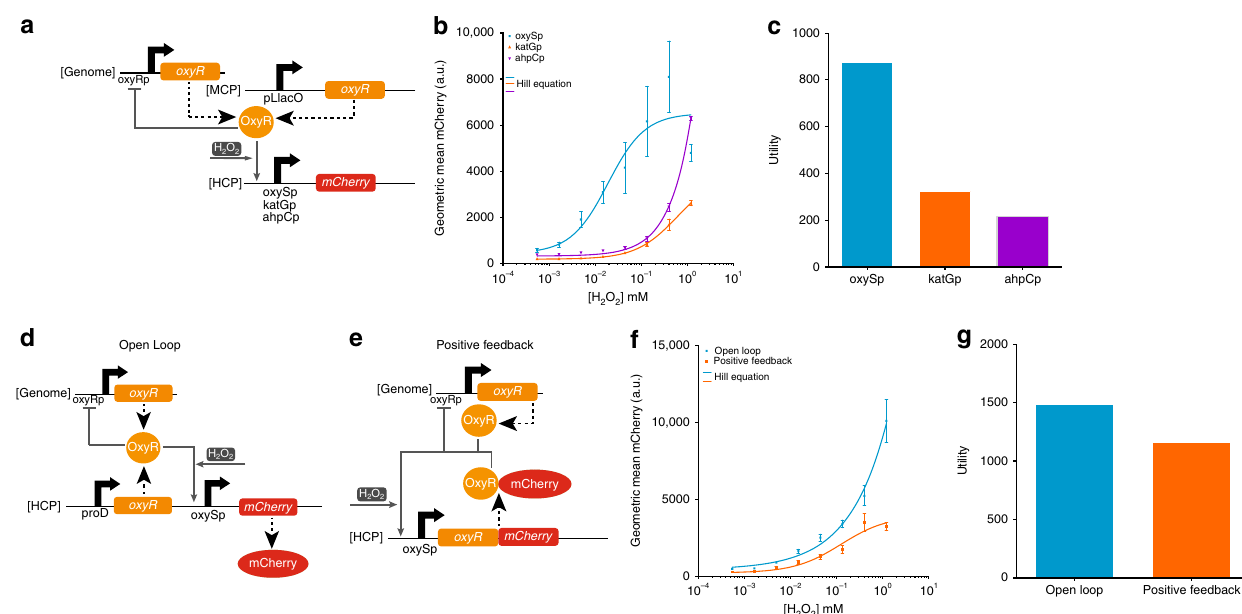
Fig. 1 H 2 O 2 -sensing synthetic gene circuits. a The open-loop (OL) circuit used to test different H 2 O 2 -OxyR regulated promoters. OxyR is expressed from an unregulated constitutive pLlacO promoter on a medium-copy plasmid (MCP), and mCherry is expressed from different OxyR-activated promoters on a high-copy plasmid (HCP). OxyR activates mCherry expression in the presence of H 2 O 2 . OxyR is also expressed from the E. coli genome and negatively regulates its own production. Dashed large arrows represent protein production and solid small gray arrows represent transcriptional regulation. b Empirical H 2 O 2 -mCherry transfer functions for three different promoters (oxySp in blue, katGp in orange, ahpCp in purple). The lines are Hill equation fi ts to the raw data. Extracellular H 2 O 2 concentrations above 1.20 mM were not tested due to toxicity. c The utility for the three different promoters calculated from the Hill functions in Fig. 1b. The circuit with the oxySp promoter has the highest utility. d The OL H 2 O 2 -OxyR-oxySp circuit. OxyR is expressed from the proD promoter and the oxySp promoter controls mCherry expression, both on a HCP. e The positive-feedback (PF) H 2 O 2 -OxyR-oxySp circuit. An OxyR- mCherry fusion protein positively regulates its own expression from the oxySp promoter on a HCP. In both the OL and PF circuits, OxyR is also expressed from the E. coli genome and negatively regulates its own expression. f The empirical H 2 O 2 -mCherry transfer function for the OL (blue) and PF (orange) H 2 O 2 -OxyR-oxySp circuits. The lines are Hill equation fi ts to the raw data. g The utility for the OL and PF H 2 O 2 -OxyR-oxySp circuits calculated using the Hill functions in Fig. 1f. The OL circuit has a higher utility. The errors (s.e.m.) are derived from three biological replicates and fl ow cytometry experiments, each involving 30,000 events. Source data are provided as a Source Data fi